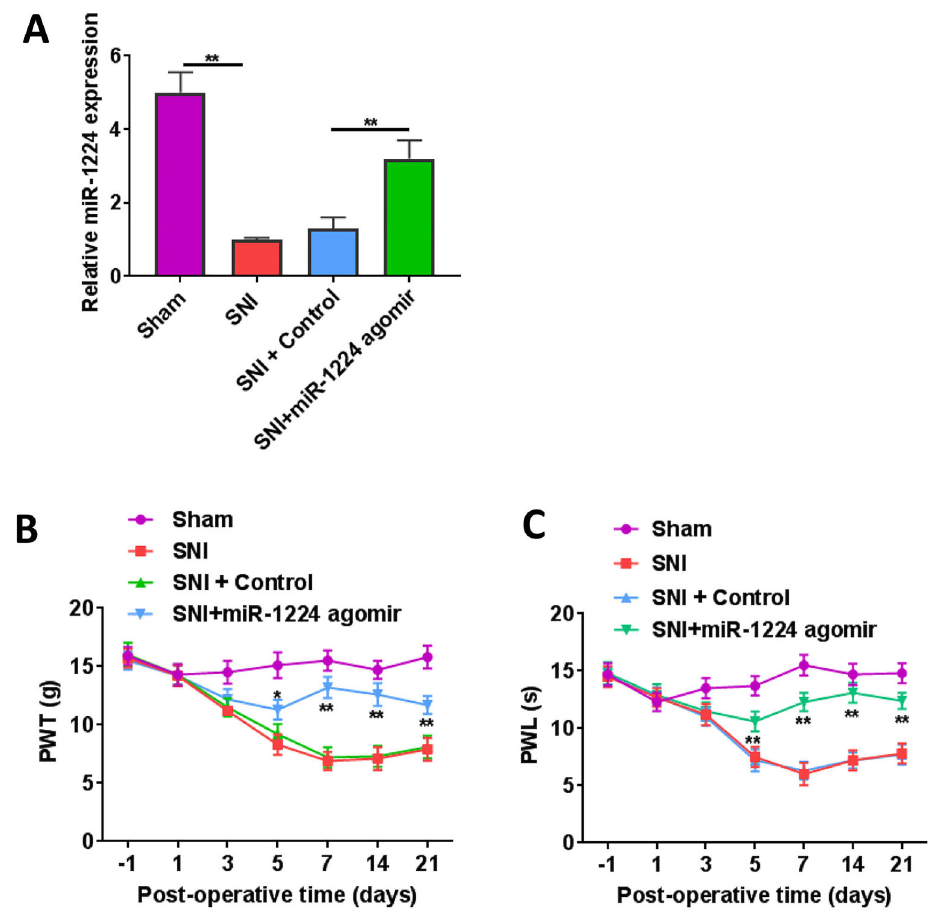
Figure 6. Effect of miR-1224 agomir on SNI-induced neuropathic pain. A , The expression of miR-1224 was veri fi ed in L3 – L6 dorsal root ganglion using real time PCR on day 21 post-operation. B , The function of miR-1224 in mechanical allodynia was measured via paw withdrawal threshold (PWT). C , The function of miR-1224 in thermal hyperalgesia was measured via paw withdrawal latency (PWL), n=5 per group. *P o 0.05, **P o 0.01 miR-1224 agomir vs control (one-way ANOVA followed by post hoc Tukey ’ s test). SNI: spared nerve injury rats; NC: sham-operated